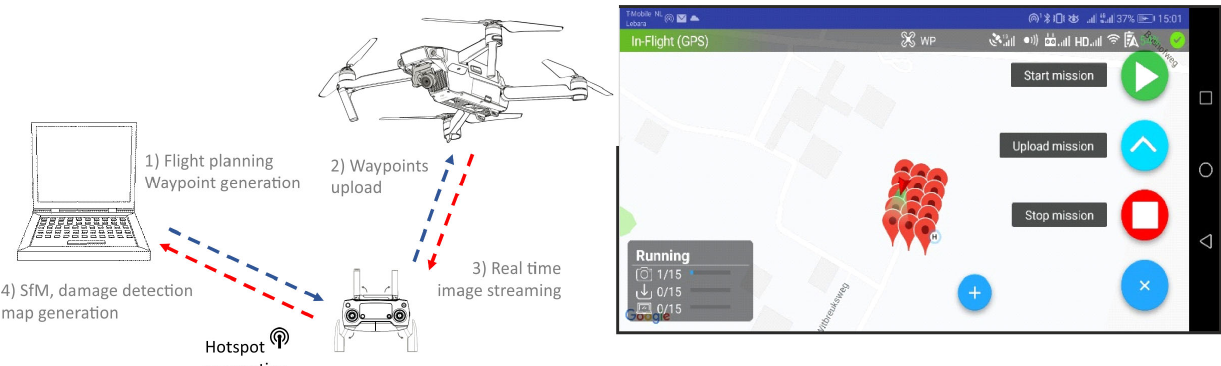
Figure 5. Work flow of the app developed for real-time damage mapping. Images are streamed to a laptop computer and processed immediately after acquisition. A CNN-based damage detection algorithm is applied, and a progressively built 3D model is used to orthorectify them. By the time the UAV lands an orthomosaic displaying the damage is